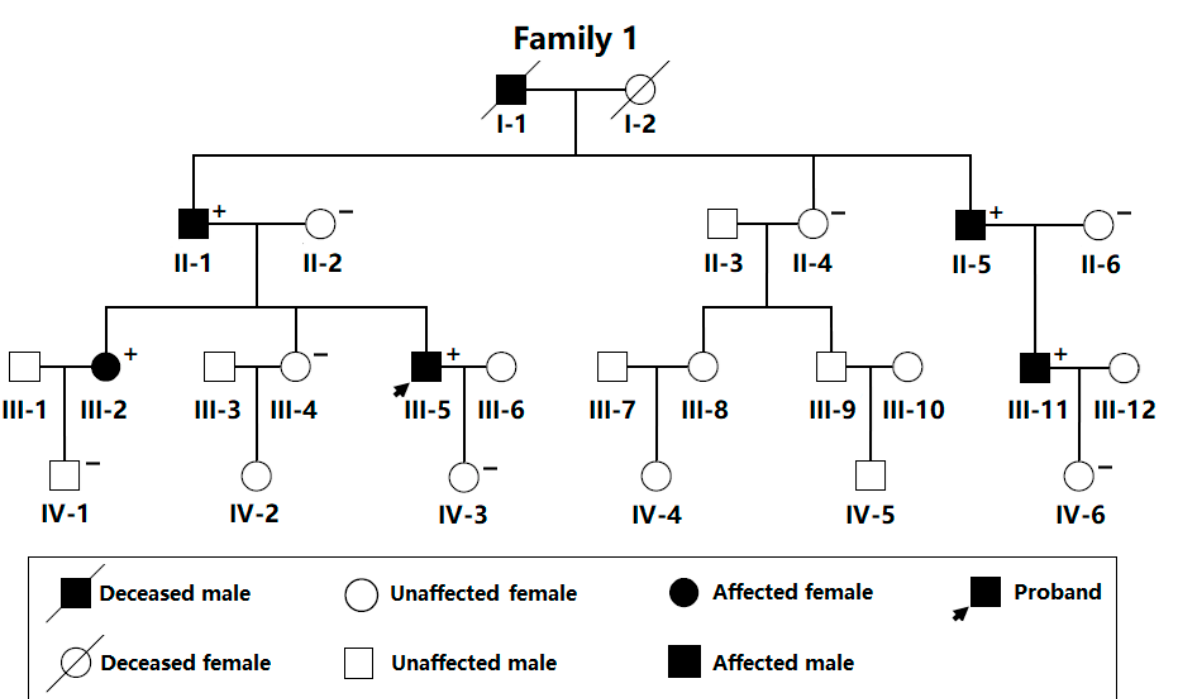
Figure 1. Pedigree of a family affected with dilated cardiomyopathy. Family members are recognized by generations and numbers (Roman–Arabic numbers). A “+” marks a carrier of the detected BMP10 variation in a heterogeneous status; “–” marks a noncarrier.